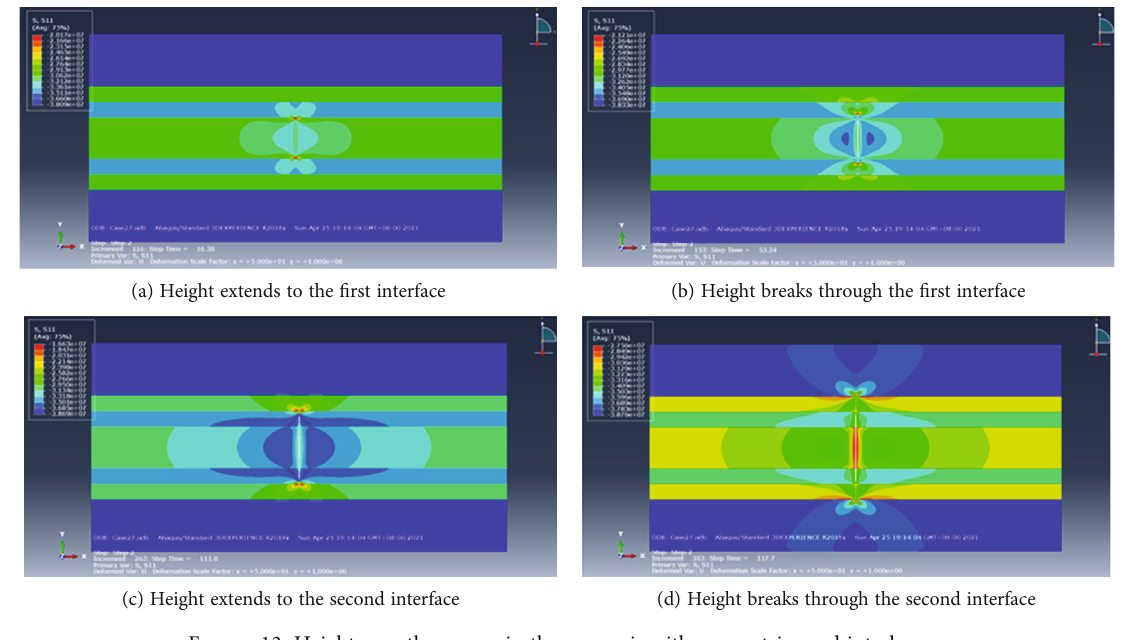
Figure 13: Height growth process in the reservoir with symmetric mud interlayers.